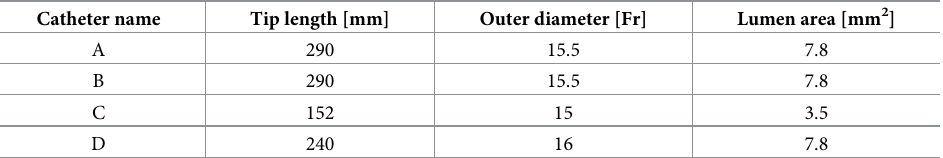
Table 1. Catheter dimensions.